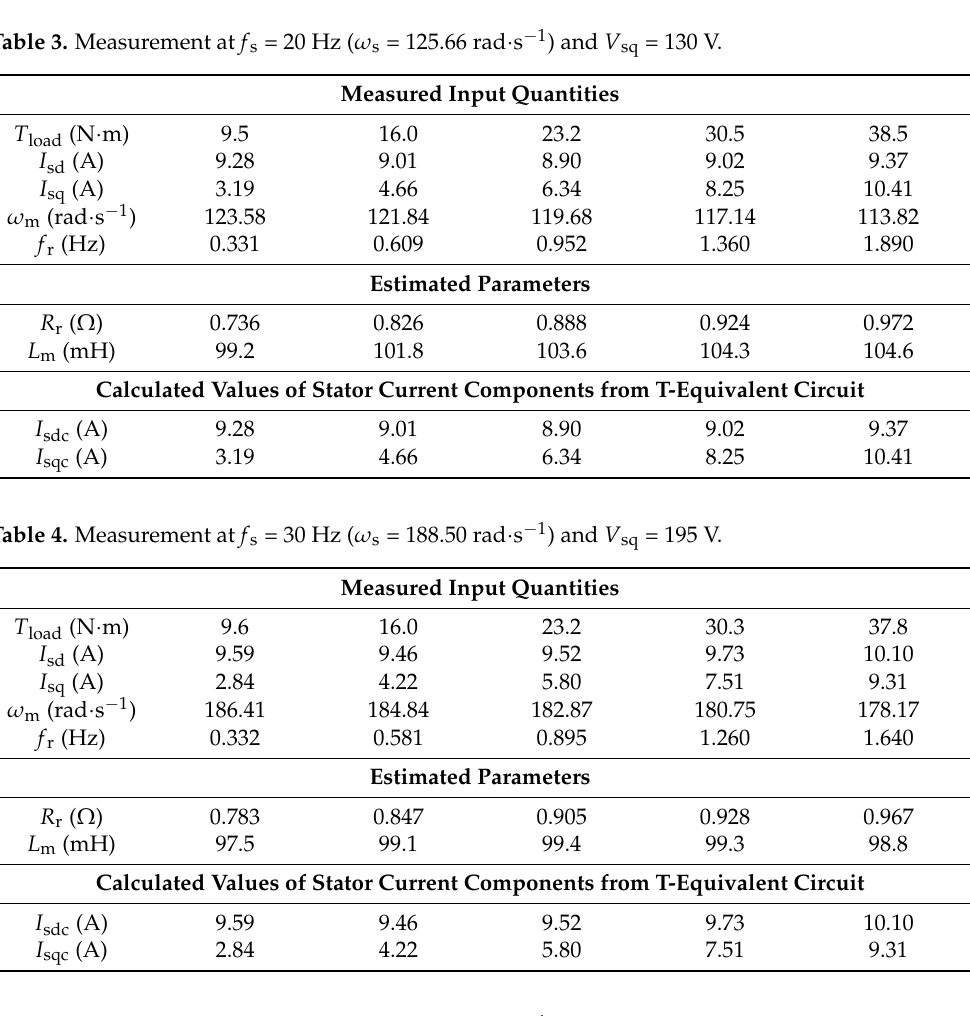
Table 5. Measurement at f s = 40 Hz ( ω s = 251.33 rad · s − 1 ) and V sq = 260